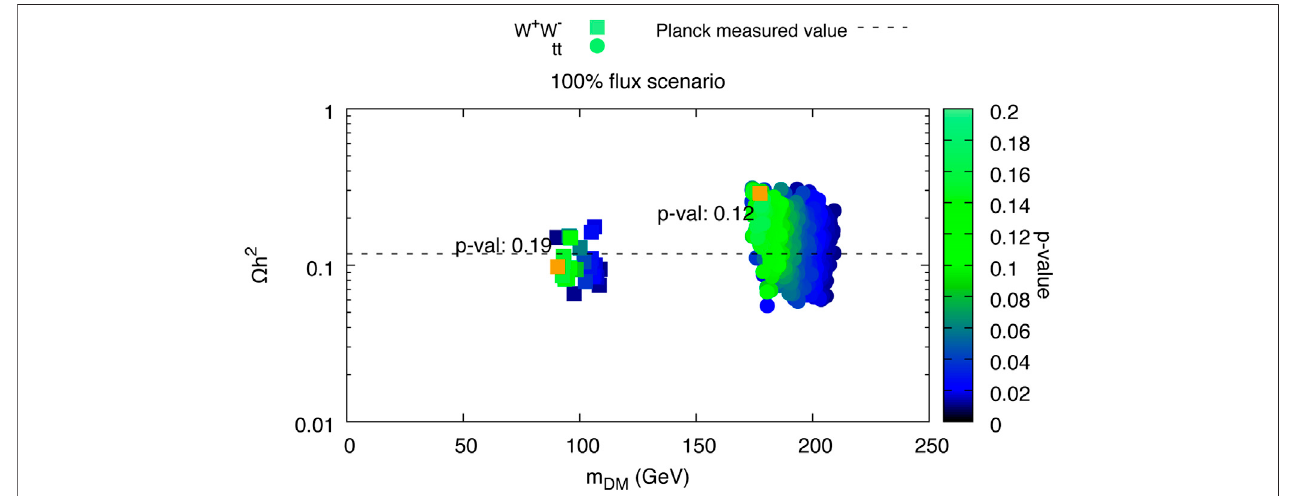
FIGURE 5 | From left the right, top to bottom, plots 6c, 7c, 7b, 8 (top left and bottom left) , 9 (top left and center left) , and 6a from Achterberg et al. (2017) are visualized using SPOT. The interactive dashboard of this data set can be accessed